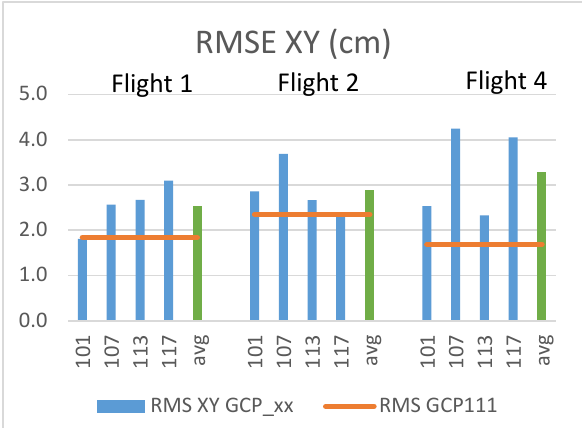
Figure 6. RMSE in horizontal coordinates at CP in four single-